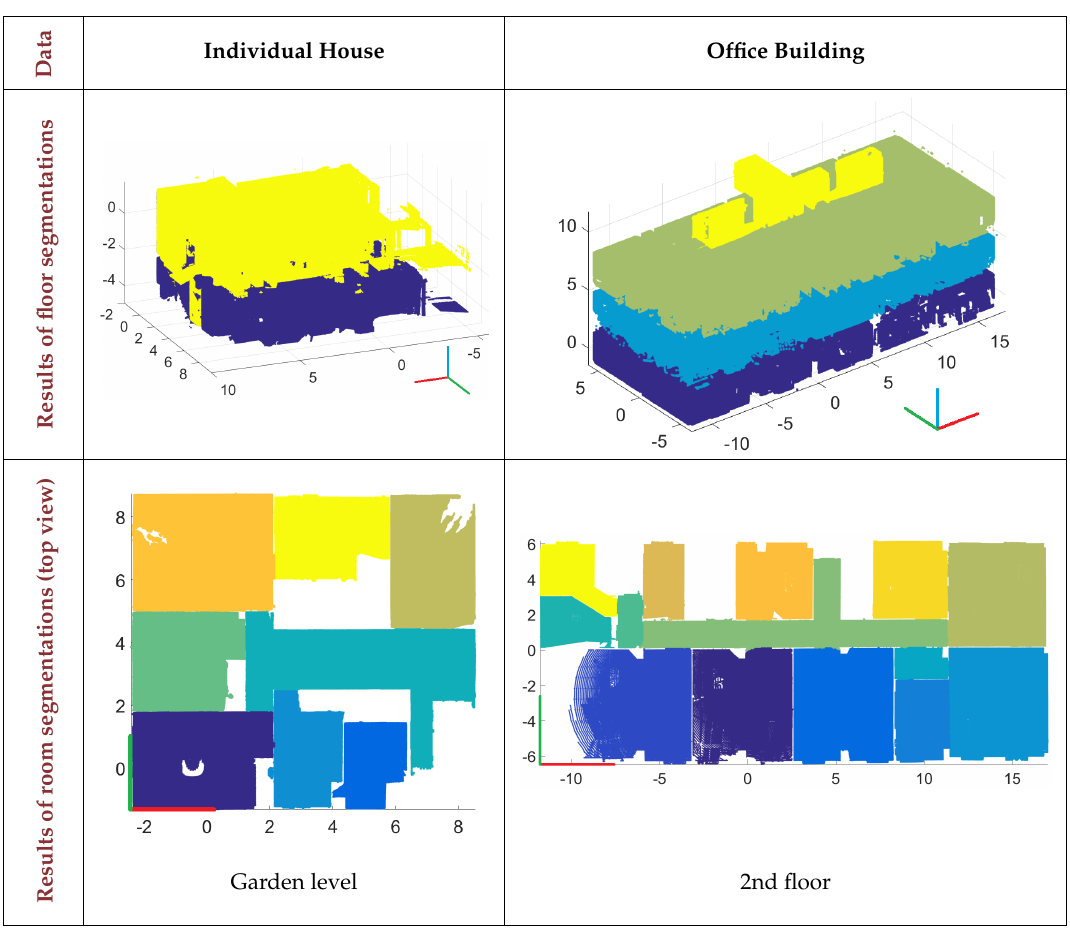
Table 2. Results of the segmentations into sub-spaces (one colour per